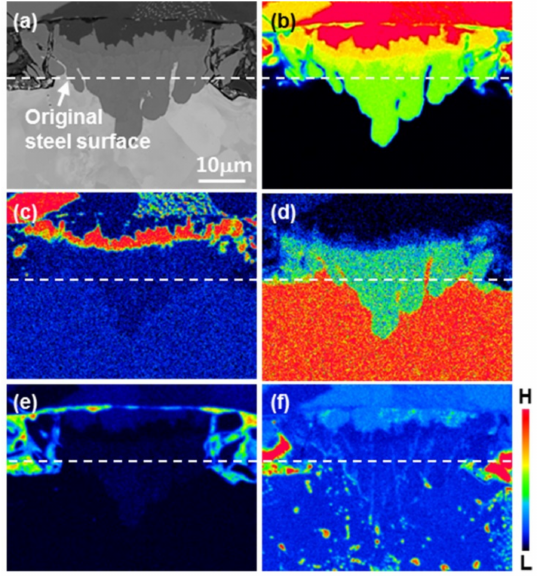
Figure 10. ( a ) BSE image and ( b – e ) results of the EPMA area analysis of the specimen (Figure 2c) hot-dipped for 20 s: ( b ) Al, ( c ) Ni, ( d ) Fe, ( e ) O, and ( f ) C.